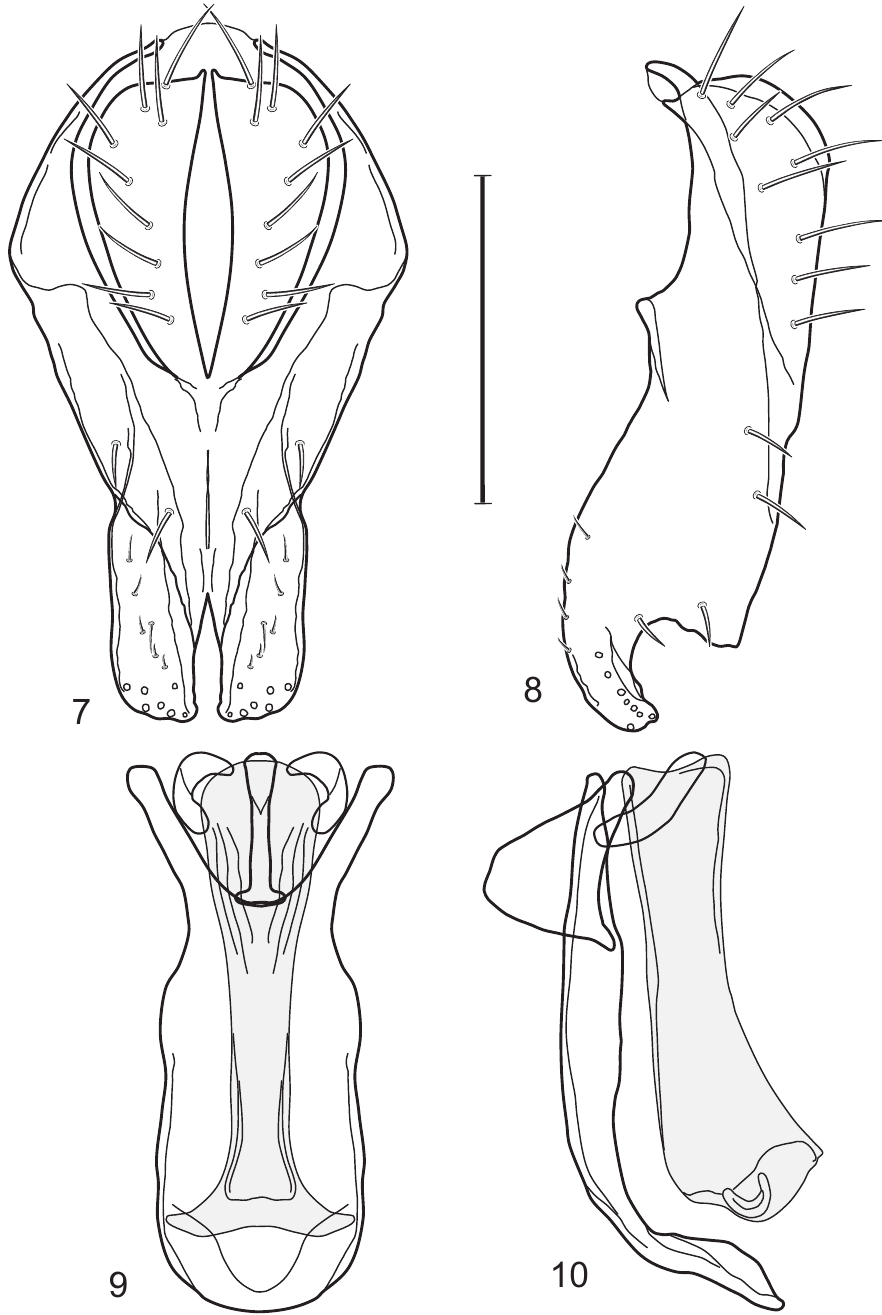
Figures 7–10. Hydrochasma crenulum sp. n. (Peru. Cuzco: Paucartambo, Atalaya) 7 epandrium and cerci, posterior view 8 same, lateral view 9 internal structures of male terminalia (aedeagus [shaded], phal- lapodeme, gonite, hypandrium), ventral view 10 same, lateral view. Scale bar = 0.1